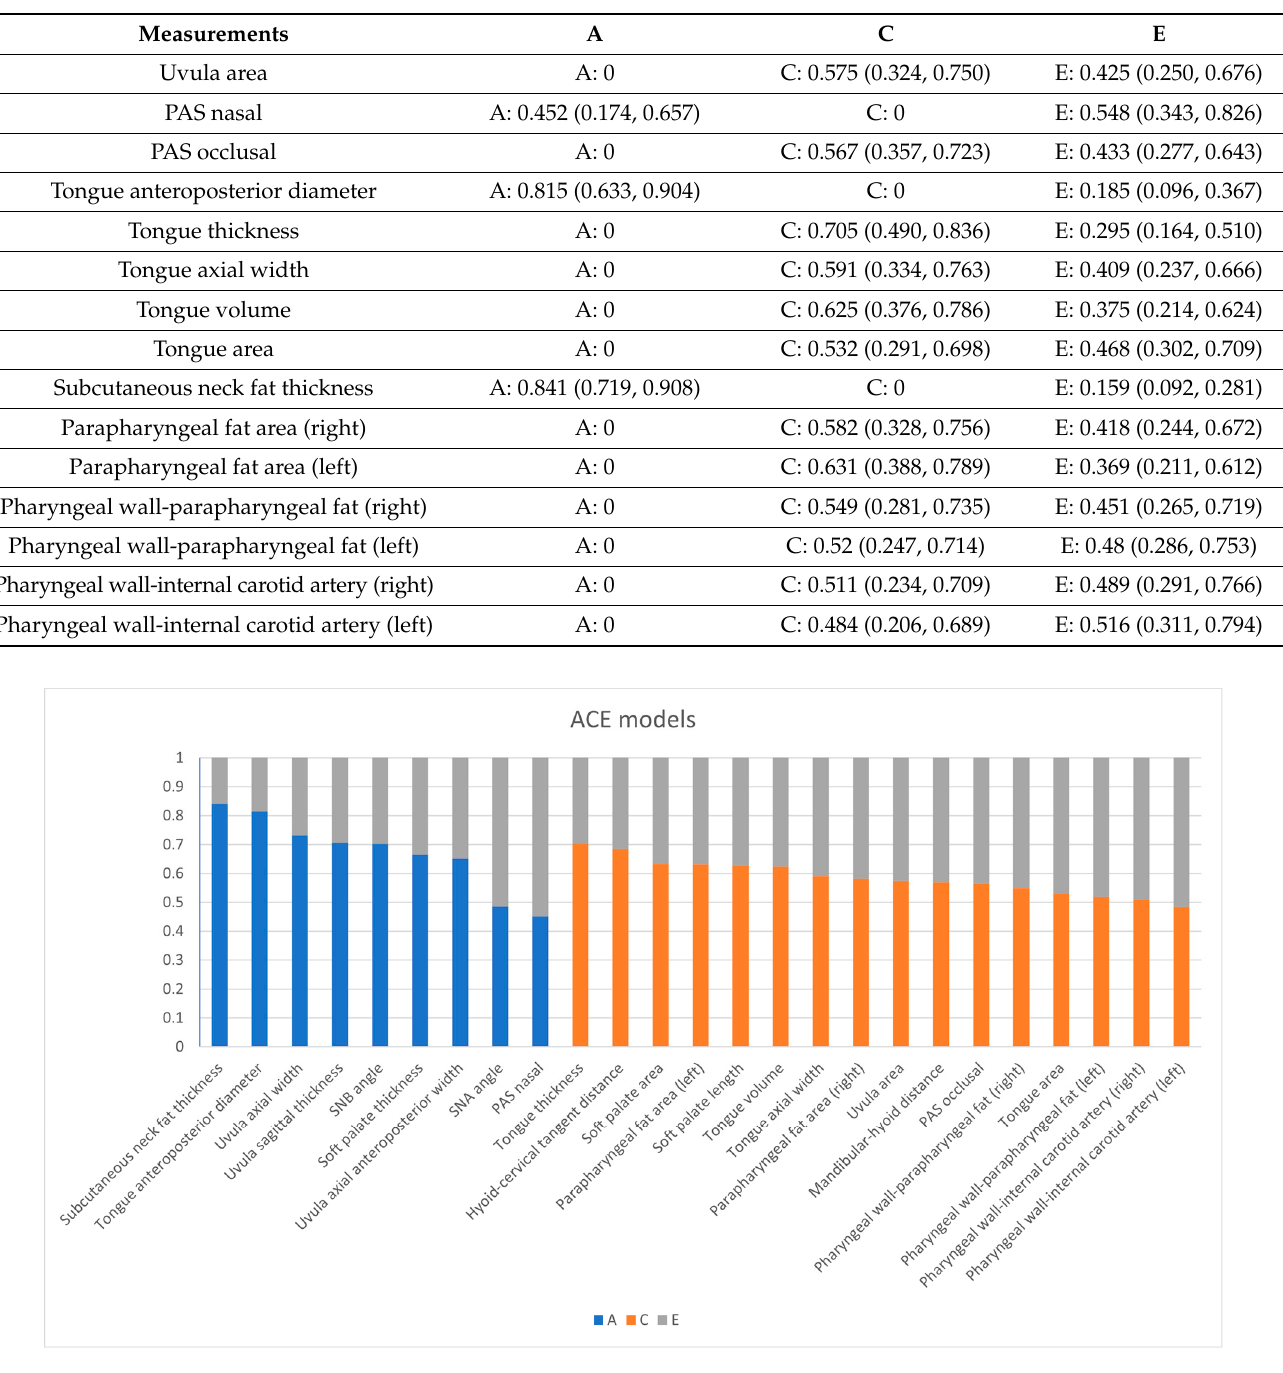
Table 3. Intraclass correlations of MZ and DZ groups RMZ: MZ correlation, RDZ: DZ correlation.